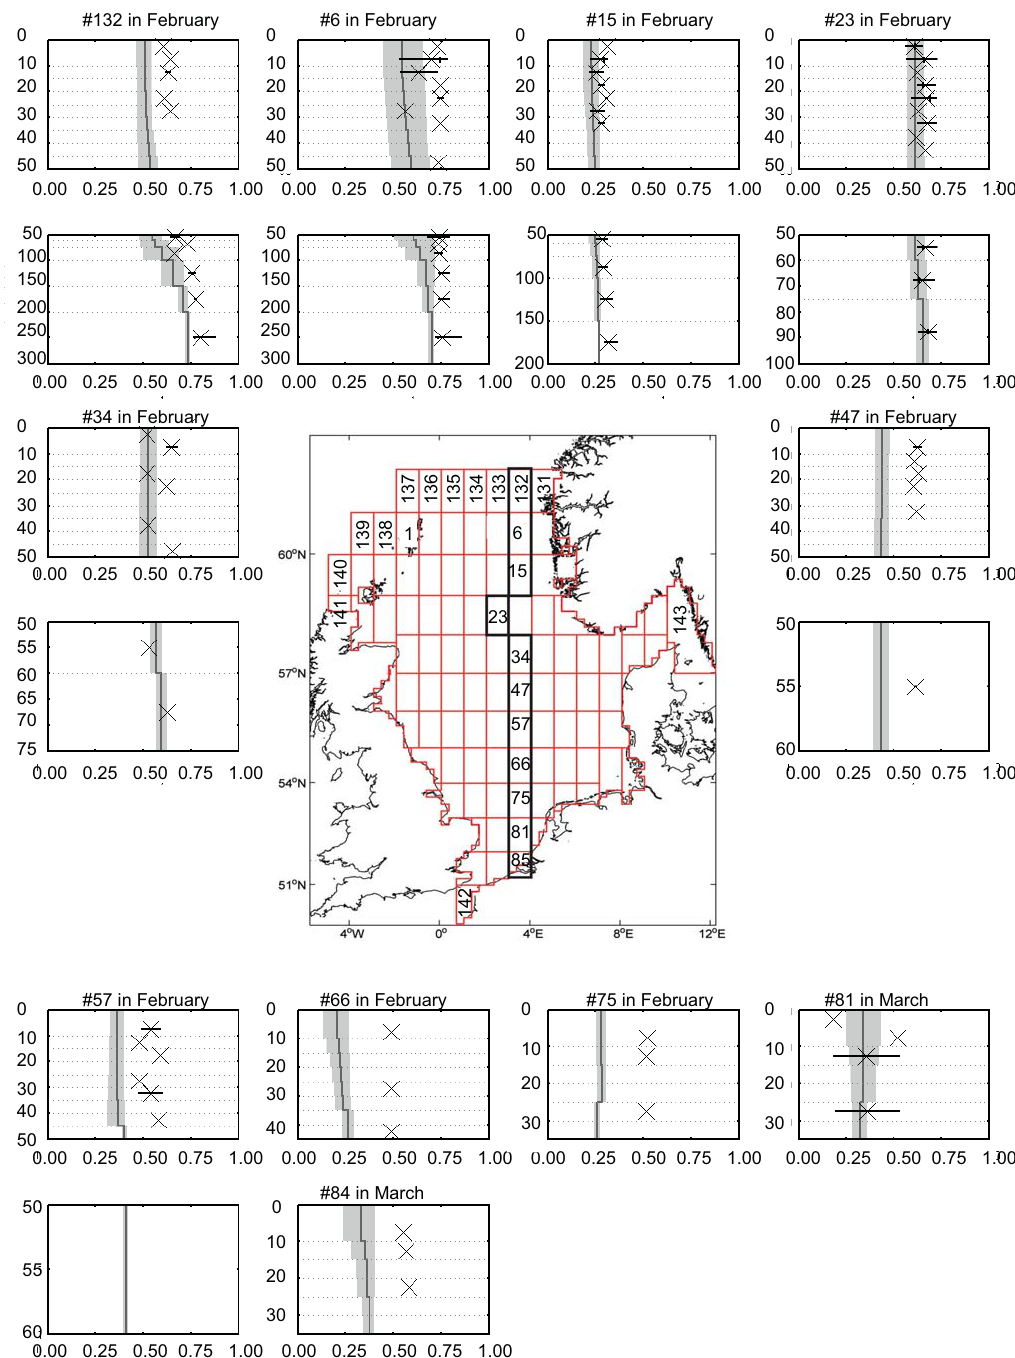
Fig. 5a. North–south transect of simulated and observed state variables as vertical profiles through the North Sea along the marked boxes. Climatological monthly means are shown for the period 1993–2008. Observations from MUDAB (Große and Moll, 2011) are indicated by crosses together with minimum and maximum bars. Simulations are indicated by the solid line. Variability is indicated by the 17 and 83% percentiles as shading around the solid line. The profiles begin with the most northern box in the top left corner and end in the most right subplot at the bottom. Vertical profiles with data observed deeper than 50m are separated into two plots for a better resolution. The lower part of the profile is always positioned directly below the upper part. Concentration on the x-axis is mmolm − 3 . (a) Dissolved phosphate in